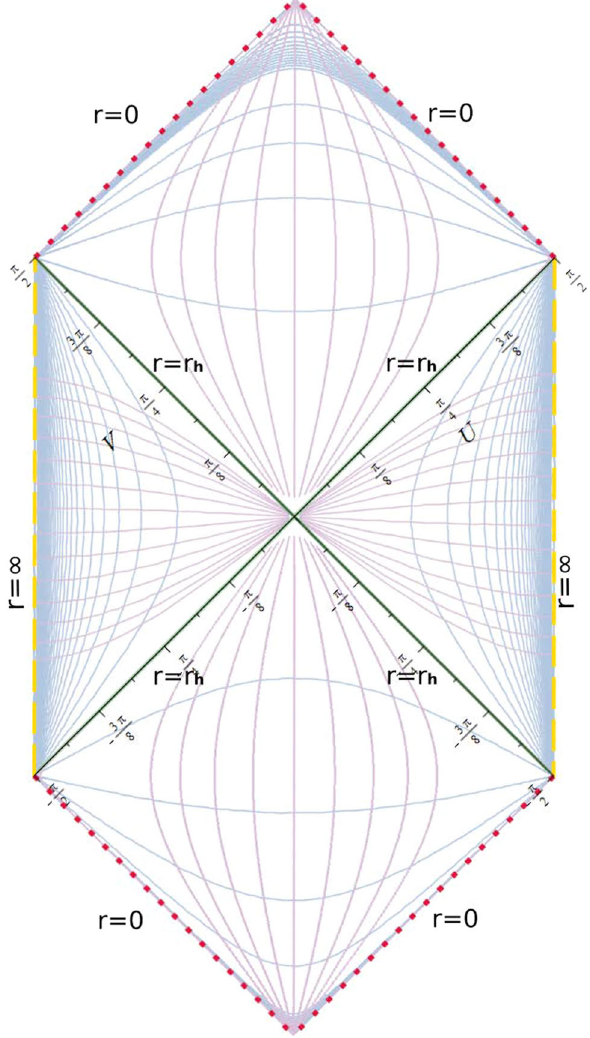
Fig. 8 Carter–Penrose diagram of the black hole spacetime con- structed in Sect.4. The central green cross represents the location of the event horizon dividing the exterior universe (left and right triangles) and the interior black hole (upper and lower diamonds). The boundary of the spacetime is located at the dashed yellow lines while the singu- larity is depicted by the dotted red lines. The special case β = z allows us to analytically scrutinize the deformed light cone structure around the black hole. The lilac and blue lines are the constant u and r null geodesics respectively represented in the compactified